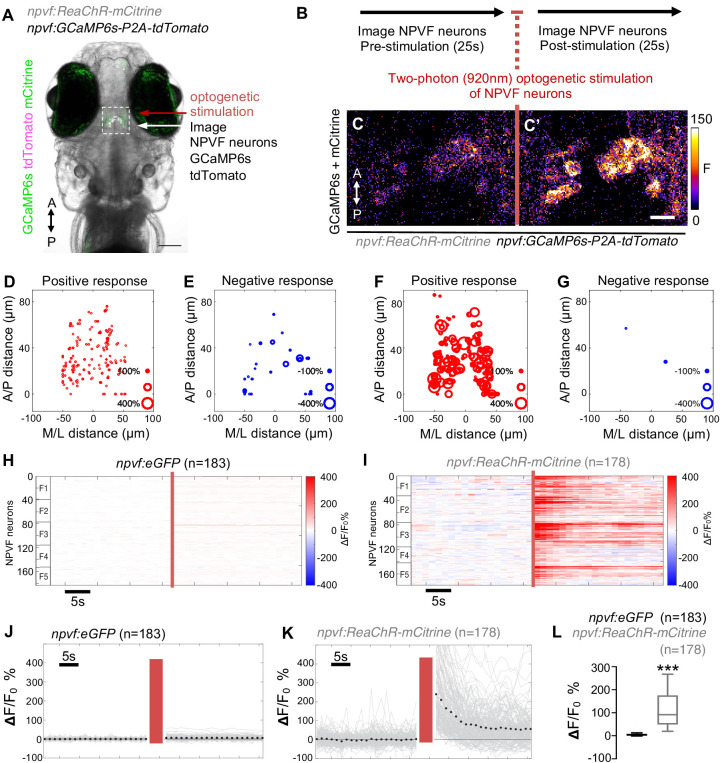
Validation of two-photon-induced optogenetic stimulation of NPVF neurons.6-dpf Tg(npvf:ReaChR); Tg(npvf:GCaMP6s-P2A-tdTomato) animals and Tg(npvf:eGFP); Tg(npvf:GCaMP6s-P2A-tdTomato) controls were analyzed for GCaMP6s fluorescence normalized to tdTomato fluorescence in NPVF neurons pre- and post-optogenetic stimulation of NPVF neurons. (A) Example of a 6-dpf Tg(npvf:ReaChR); Tg(npvf:GCaMP6s-P2A-tdTomato) animal showing GCaMP6s and tdTomato fluorescence in NPVF neurons. Green and magenta signals in the eyes are due to autofluorescence. White box indicates the region of the hypothalamus that was stimulated and analyzed in subsequent panels. (B) Normalized GCaMP6s fluorescence in NPVF neurons was first recorded for 25 s (20 frames) at low-laser power. NPVF neurons were then optogenetically stimulated at higher laser power, and then normalized GCaMP6s fluorescence in NPVF neurons was immediately imaged again for 25 s (20 frames) at low-laser power. (C,C’) GCaMP6s and mCitrine fluorescence in NPVF neurons recorded one frame before (C) and after (C’) optogenetic stimulation of NPVF neurons. (D–G) Positive or negative normalized GCaMP6s fluorescence responses to optogenetic stimulation of individual NPVF neurons plotted according to their spatial location along the anterior/posterior and medial/lateral axes of the brain. The size of red or blue circles indicates the magnitude of increase or decrease of normalized GCaMP6s fluorescence, respectively. A, anterior; P, posterior; L, lateral; M, medial. ‘0’ along the A/P axis indicates location of the most posterior NPVF neurons. ‘0’ along the M/L axis indicates the midline of NPVF neuron population. (H-K) Normalized GCaMP6s fluorescence of individual NPVF neurons shown as heat maps (H,I), in which each horizontal line represents an NPVF neuron, and as line graphs (J,K) showing individual (gray lines) and mean (dotted line) normalized GCaMP6s ΔF/F0 % values before and after optogenetic stimulation (red lines) in Tg(npvf:eGFP); Tg(tph2:GCaMP6s-P2A-tdTomato) control (H,J) and Tg(npvf:ReaChR-mCitrine); Tg(tph2:GCaMP6s-P2A-tdTomato) (I,K) animals. F1-F5 in (H,I) indicate neurons from five different fish. (L) Box plot of normalized GCaMP6s ΔF/F0 values averaged for the first 10 imaging frames post-stimulation in Tg(npvf:GCaMP6s-P2A-tdTomato) animals that also contain either a Tg(npvf:eGFP) (black) or Tg(npvf:ReaChR-mCitrine) (gray) transgene. n = number of neurons. ***p<0.0005, Mann-Whitney test. Scale: 100 μm (A), 10 μm (C’).